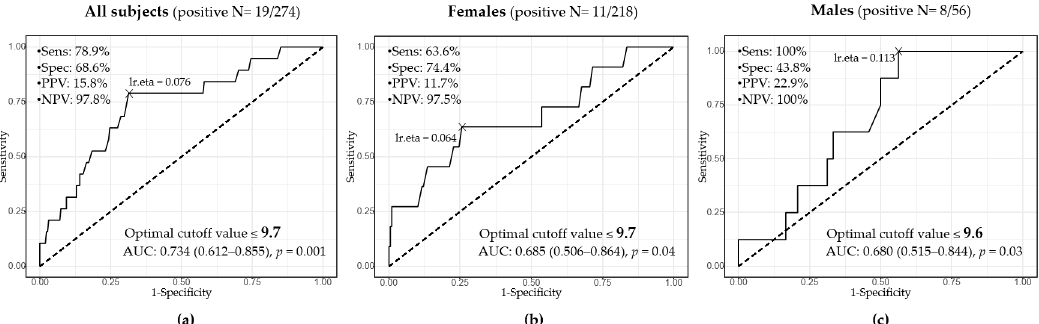
Figure 2. Box-and-whisker dot plots. Two group comparisons of serum adiponectin levels with or without multiple metabolic syndrome components ( ≥ 2) in all subjects ( a ), females ( b ), and males ( c ). An independent two-sample test ( t -test or Mann – Whitney test) was used after the normality test.